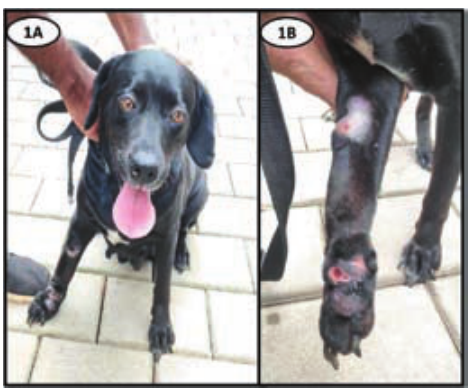
Fig. 1A: The dog presented with limb oedema & localized alopecia; 1B: The edematous right forelimb with ulcerated non-healing wounds could be noted